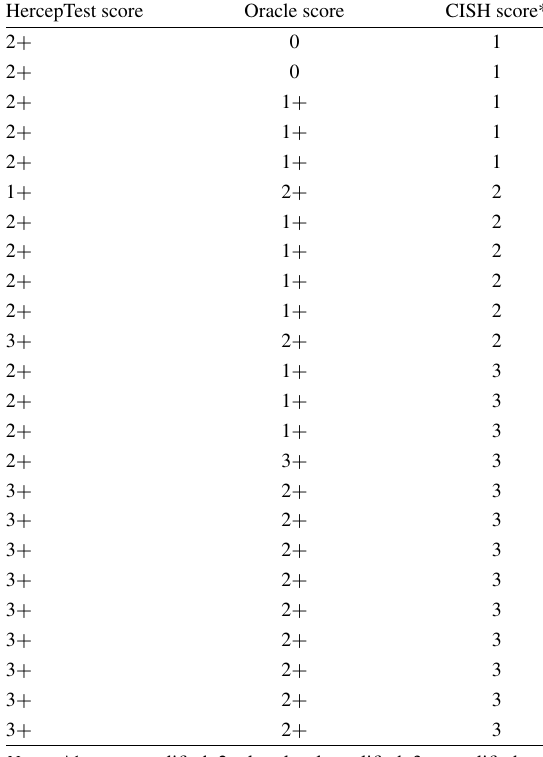
Concordance between the manual polyclonal antibody-based Her- HER2 chromogenic in situ hybridization (CISH) amplification cepTest and chromogenic in situ hybridization (CISH) in 219 breast scores for 24 discrepancies between HercepTest and Oracle HER2 cancers staining from an original group of 219 breast CISH